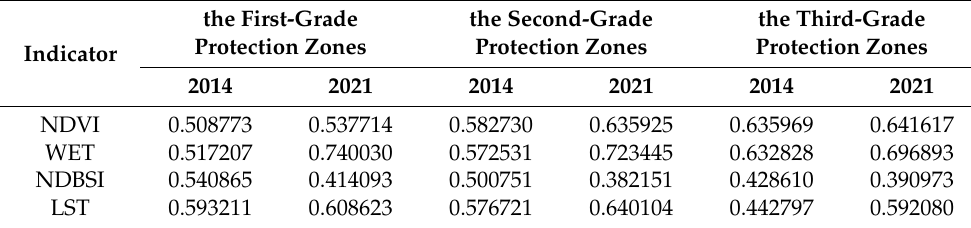
Table 5. Ecological factor index of different governance areas in